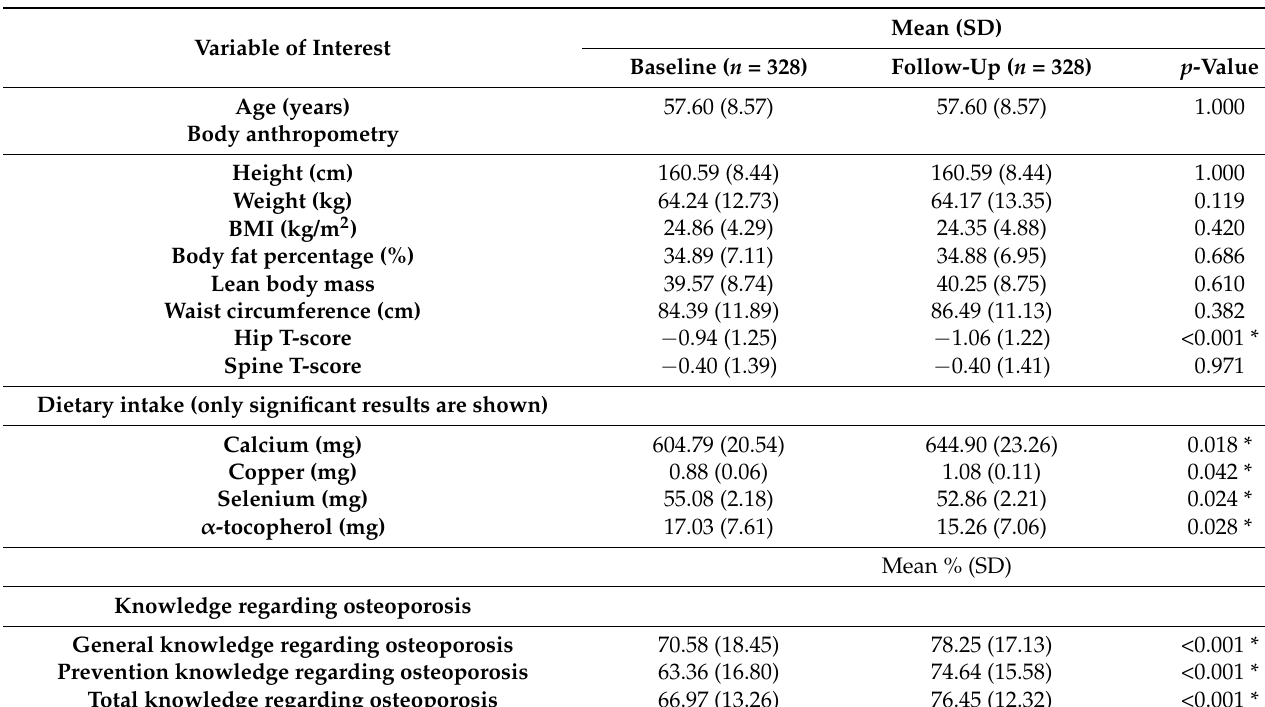
Table 3. Characteristics of subjects before and after the